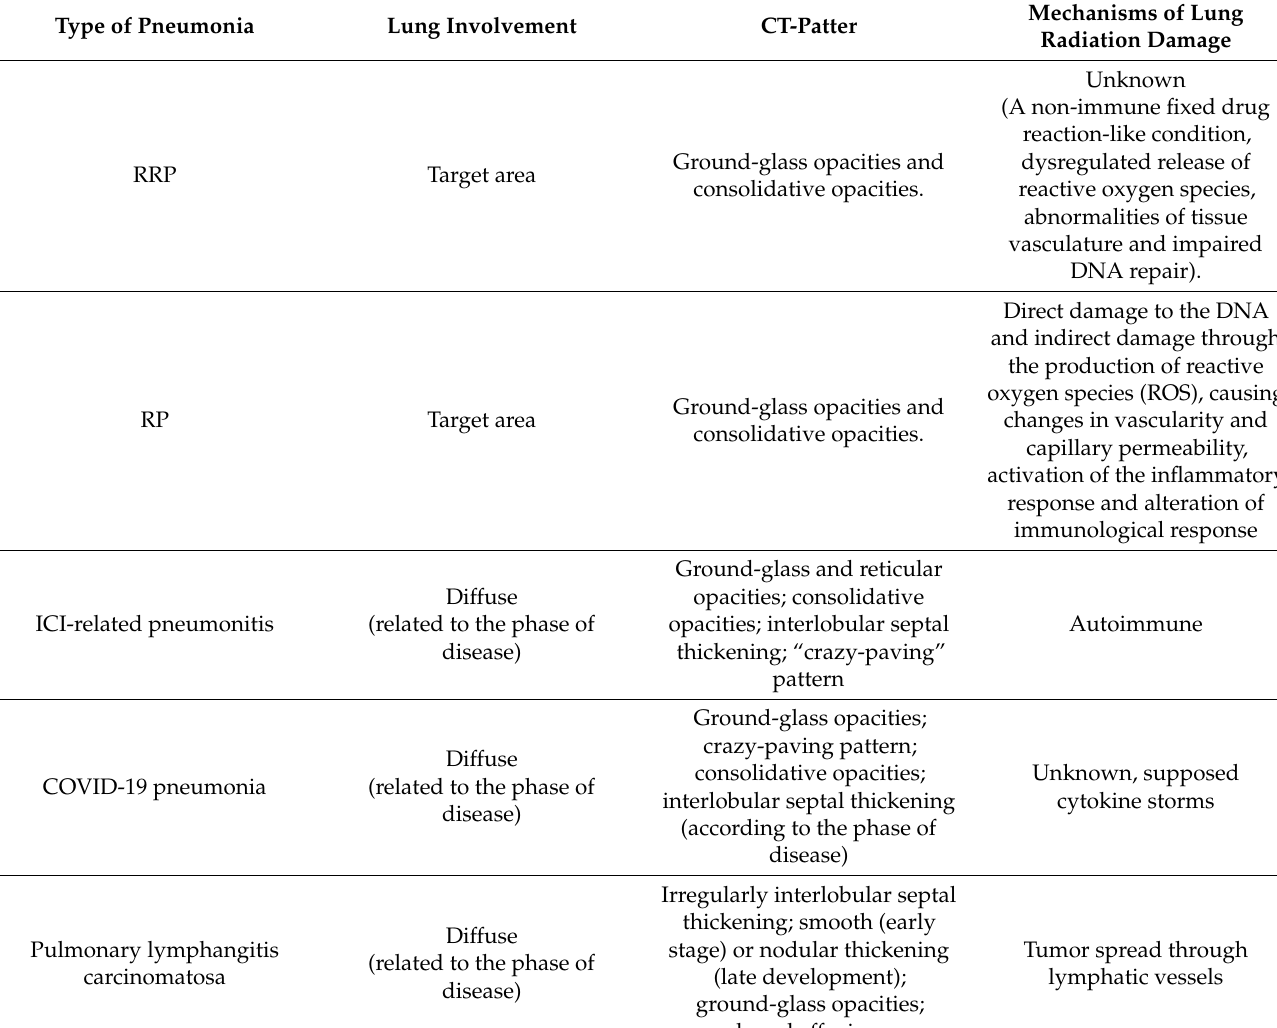
Table 1. Lung involvement and CT pattern for pneumonia